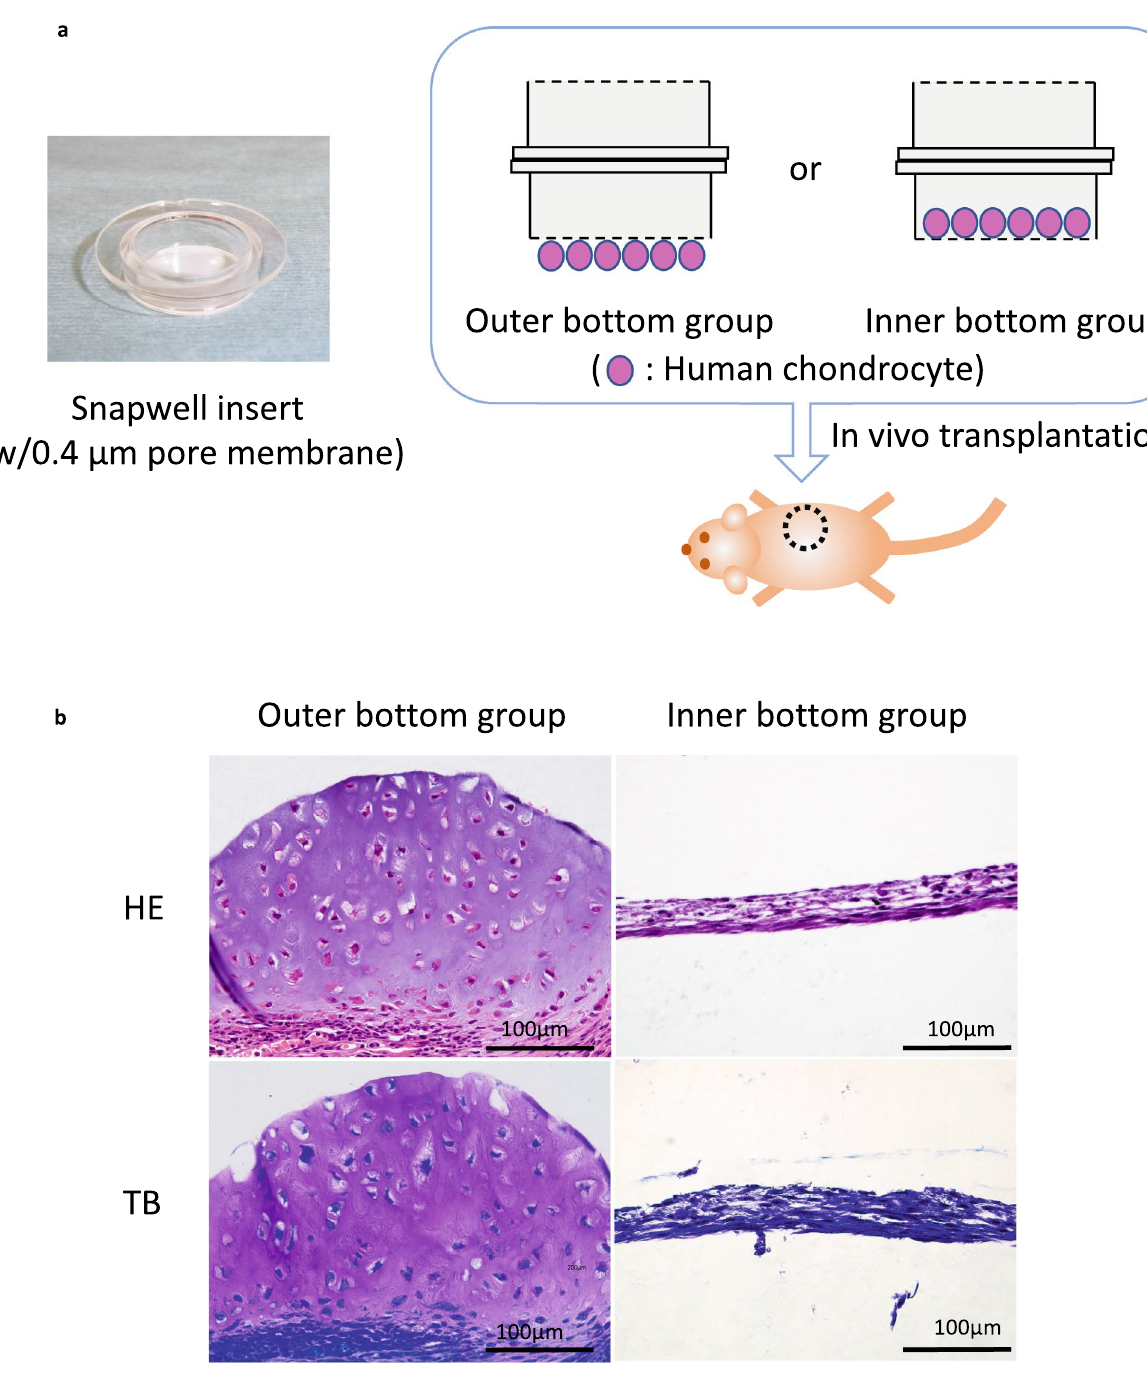
Figure 1. ( a ) Snapwell insert and schematic of the device (inner and outer bottom groups). ( b ) Histological images of the transplanted chondrocytes at 4 weeks posttransplantation(HE: haematoxylin & eosin staining, TB: toluidine blue staining). Cartilage matrix was formed only in the outer bottom HUVECs were significantly smaller than those of the tissues in the device containing only chondrocytes (thick- ness: p < 0.001, area: p < 0.01). Pretreatment of RAW264.7 cells before transplantation. Macrophages can be polarized into sev- eral subgroups. Generally, M1 macrophages are inflammatory, while M2 macrophages suppress inflammation and induce tissue repair 30,31 . To examine the effects of different macrophage subtypes on chondrogenesis, 3 types of RAW264.7 cells were prepared and then added to the inner bottom. We compared populations of cells in the region where top 10% of untreated RAW264.7 cells positive for CD206 and CD80 were included (defined as